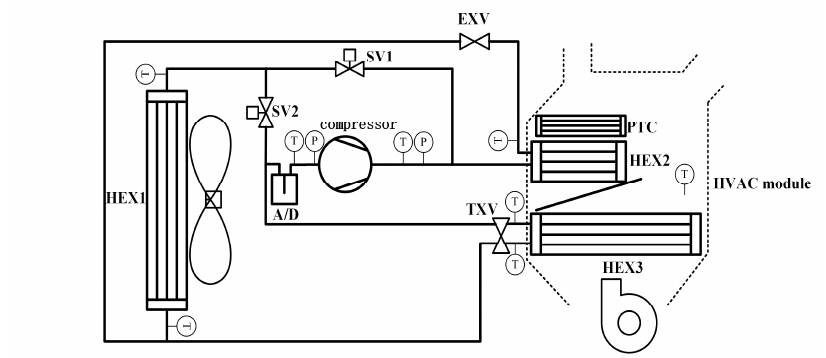
Figure 1. The schematic of an air-conditioning heat pump (ACHP) system.